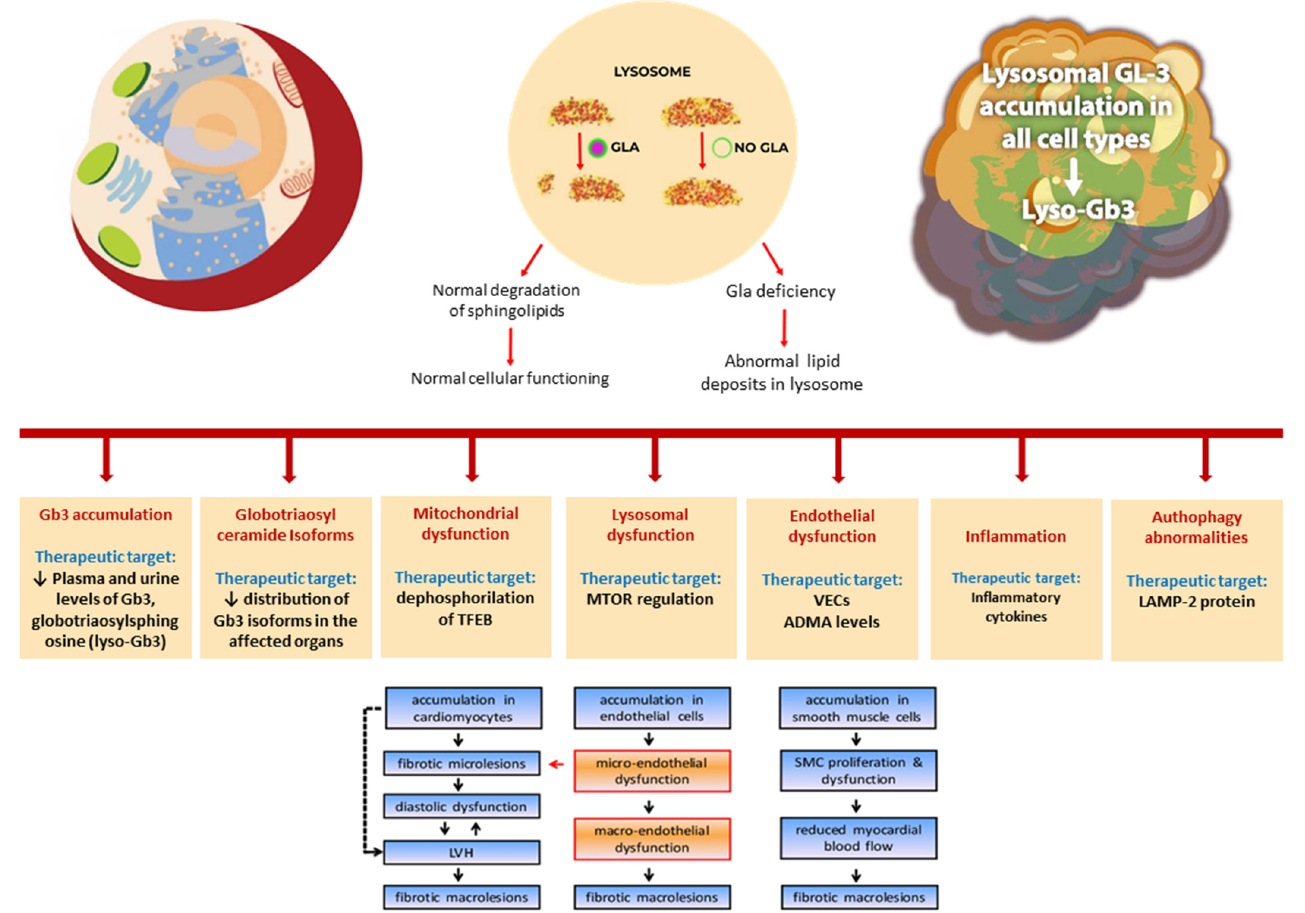
Figure 1. Molecular and cellular alterations involved in pathogenesis of Anderson–Fabry